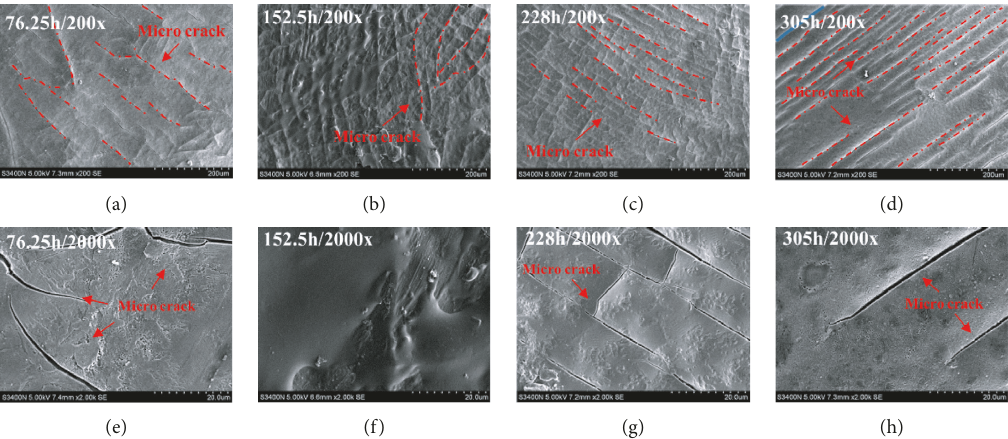
Figure 7: 70# base asphalt under different UV aging times of microscopic morphology. (a) 76.25 h-200 times. (b) 152.5 h-200 times. (c) 228 h-200 times. (d) 305 h-200 times. (e) 76.25 h-2000 times. (f) 152.5 h-2000 times. (g) 228 h-2000 times. (h) 305 h-2000 times.